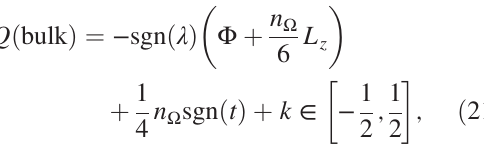
TABLE II. Shift insulator disclination charge for t ¼ 1 and